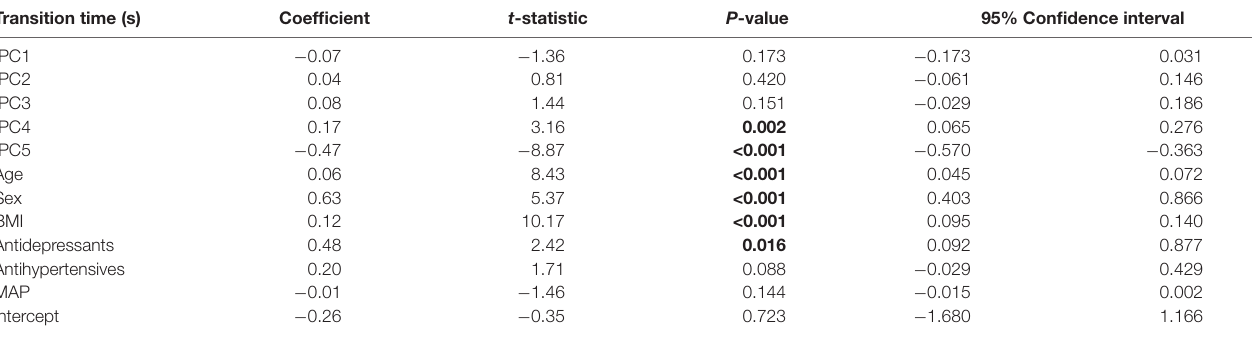
Adjusted R 2 = 0.12, p-values <